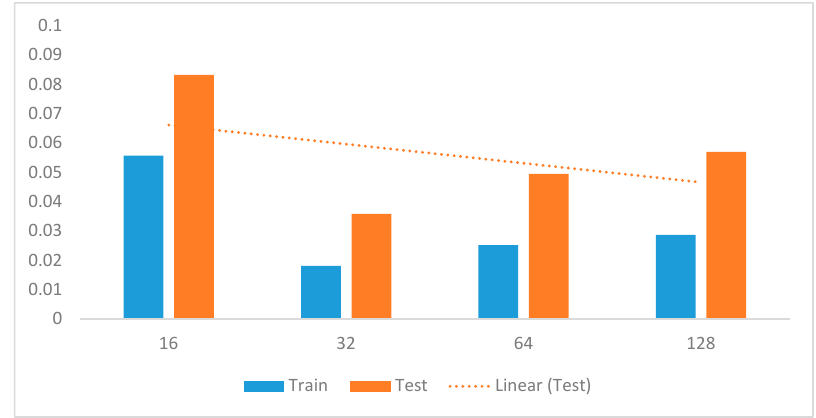
Figure 13. Recognition accuracy with different window sizes overlapping at 50%.